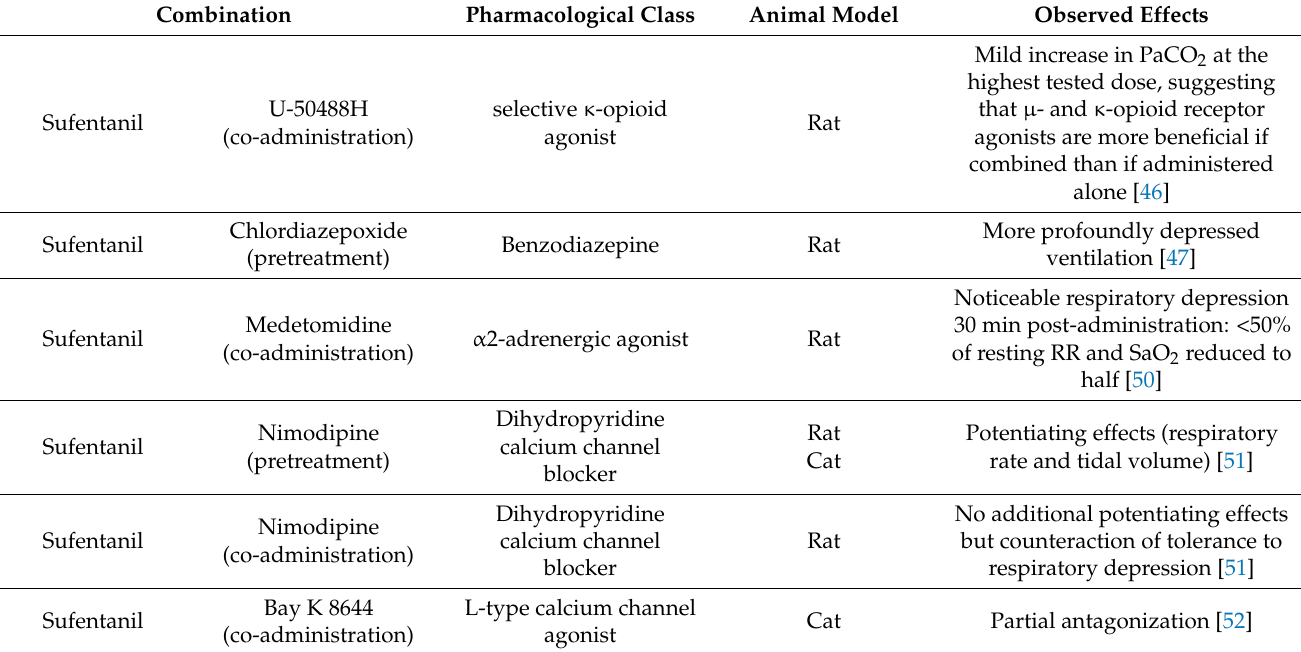
Table 1. Effects of sufentanil drug combinations on respiratory